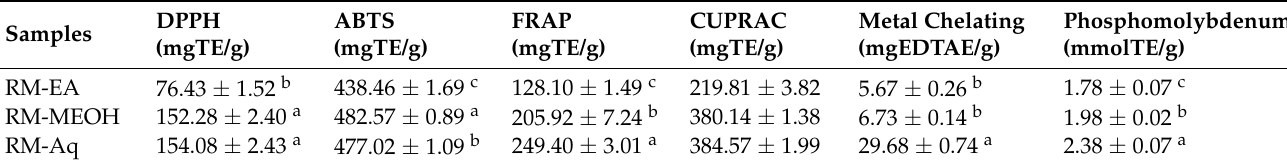
Table 3. Antioxidant potential.